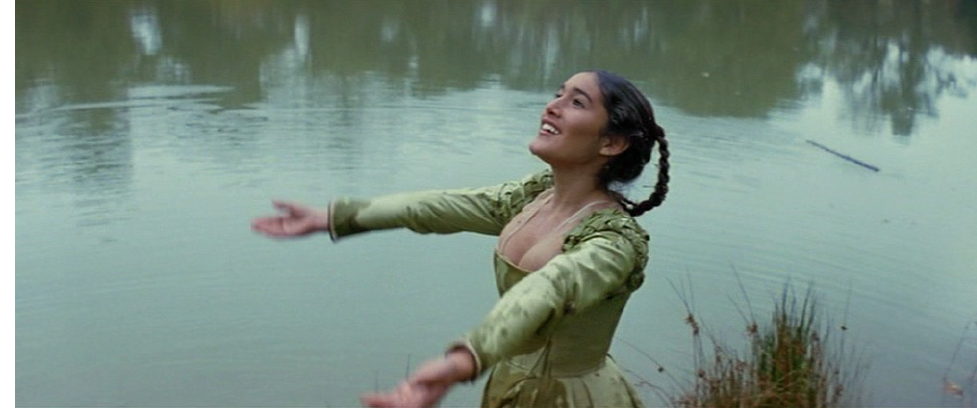
Figure 4: Pocahontas’ skyward salutation is done near water perhaps echoing her return to that world of unqualified joy dramatised in the film’s opening (pre-European arrival) swimming